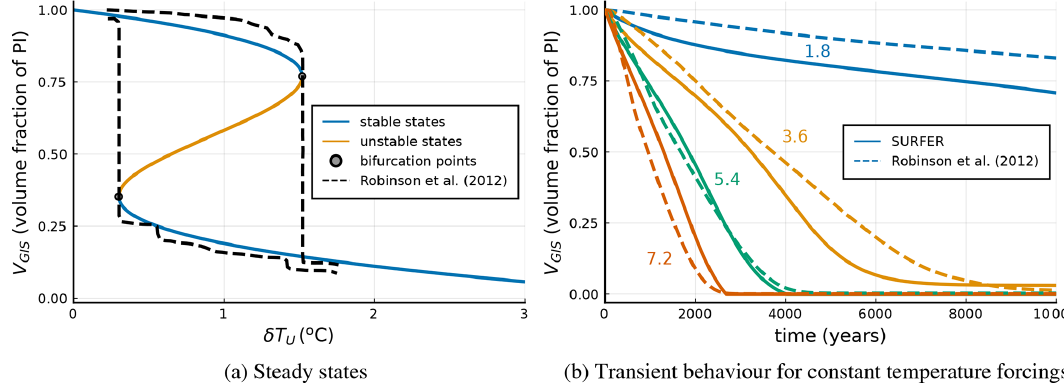
Figure 7. SURFER’s Greenland ice sheet against the work of Robinson et al. (2012).